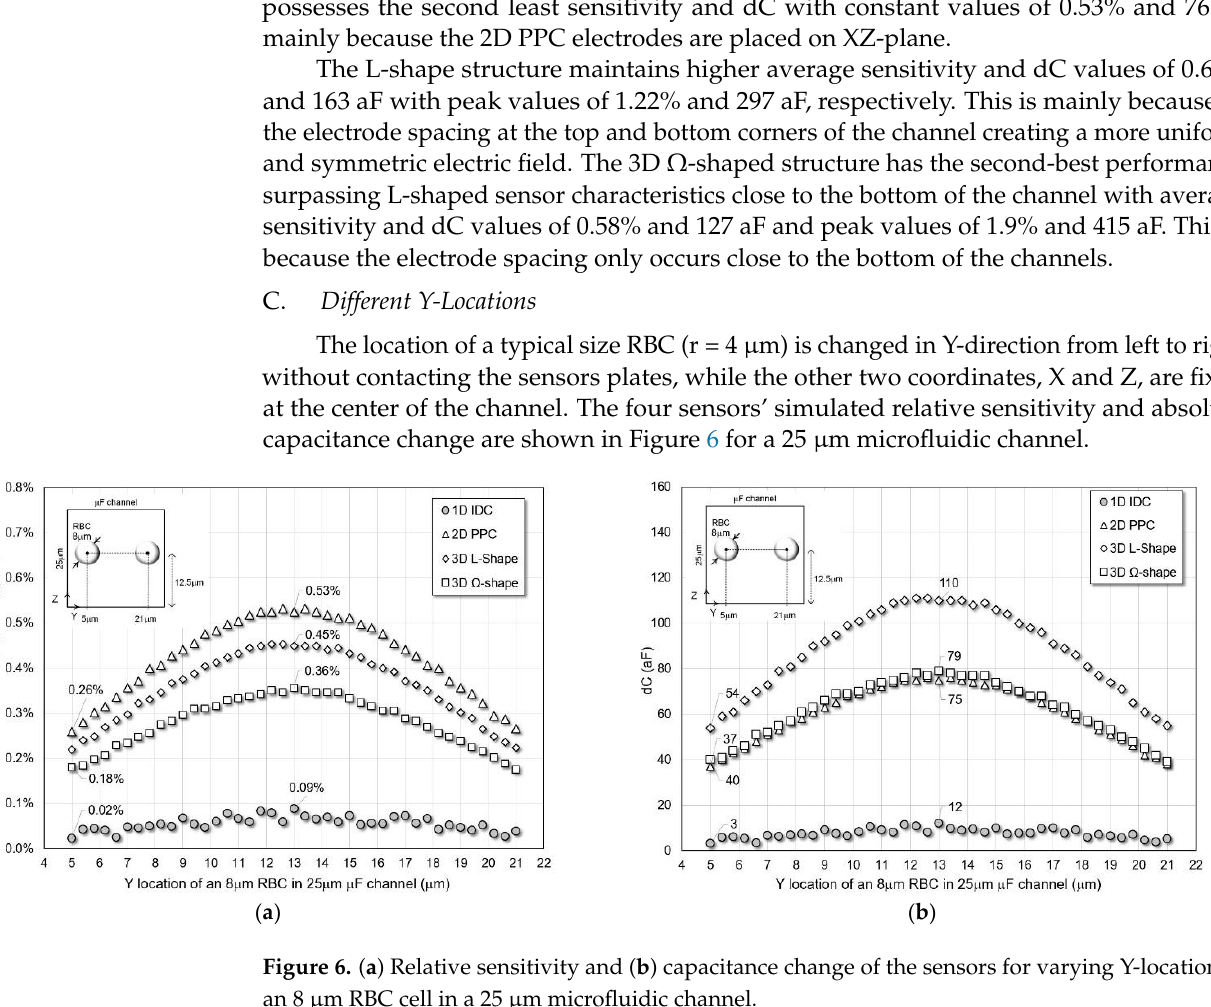
Figure 7. ( a ) Relative sensitivity and ( b ) capacitance change of the sensors for varying X-location of an 8 μm RBC cell in a 25 μm microfluidic channel.